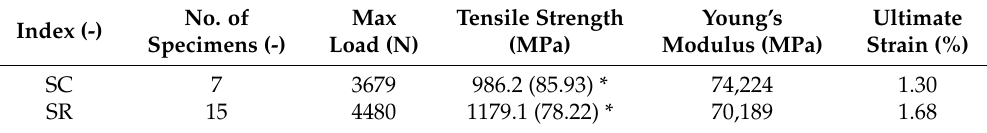
* standard deviation.